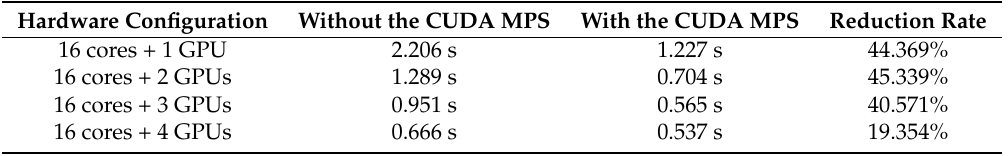
Table 3. Reducing execution time of the GPU by using the CUDA